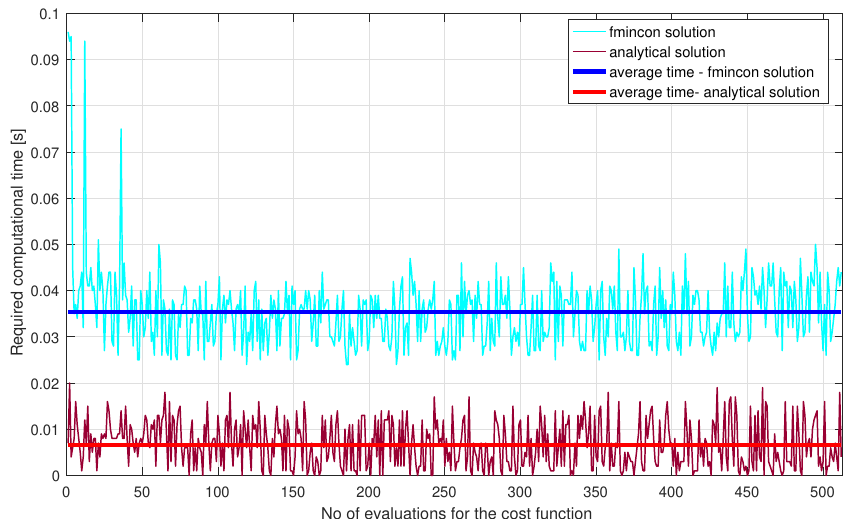
Figure 7. Required computational